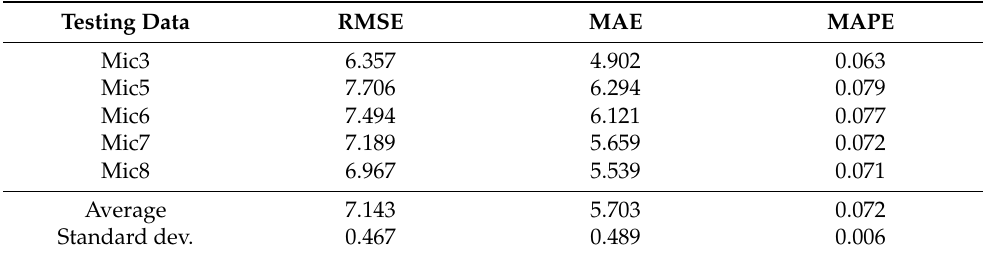
Table 8. The evaluations on the common noise assessment methods (CNOSSOS)